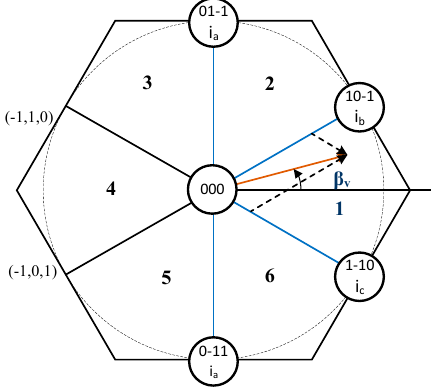
Figure 6. Space vector diagram and the selected vectors for zero common voltage.